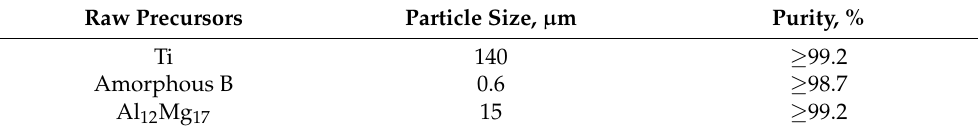
Table 1. Characteristics of the raw